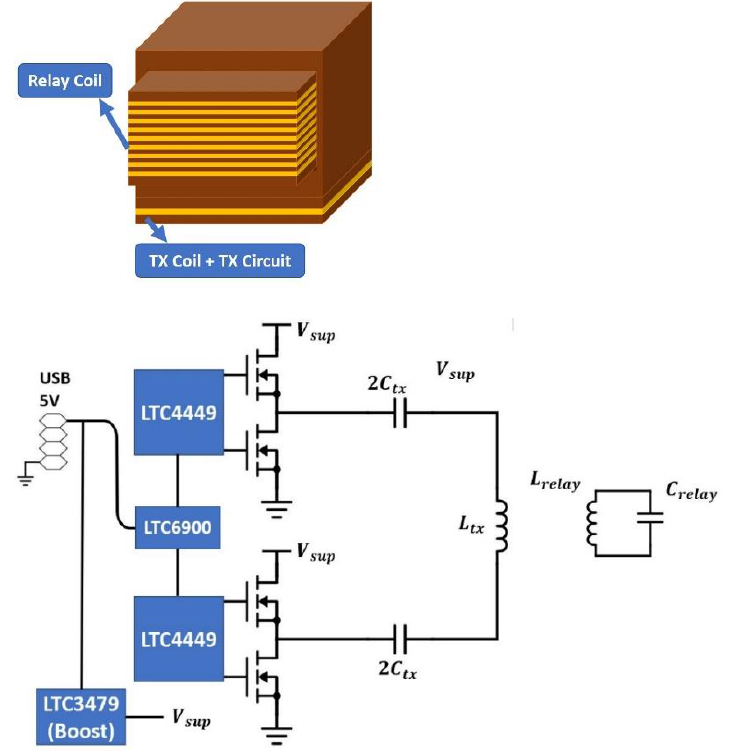
Figure 11. System implementation and schematic of the wireless-charging drawer. Table 4. Properties of the wireless-charging drawer ’s TX coil and relay coil.